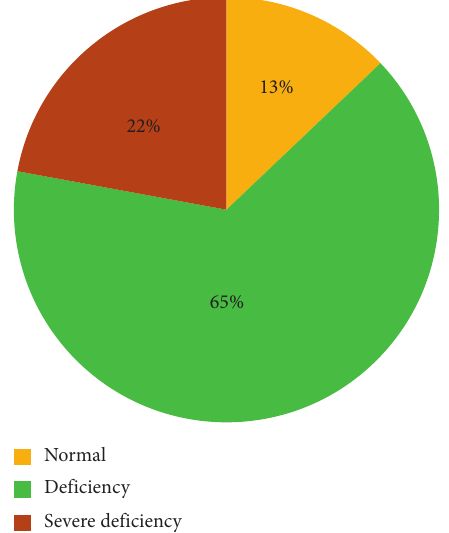
Figure 1: Distribution of 25 (OH)D values among 163 hemodi- alysis